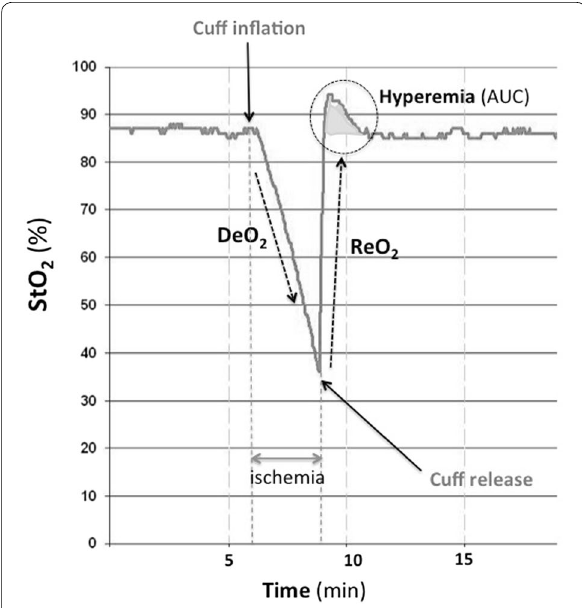
Fig. 1 StO 2 response to the Vascular Occlusion Test (VOT). The response to transient ischemia generates three main parameters in the continuous StO 2 recording: the StO 2 deoxygenation rate (DeO 2 ), the StO 2 reoxygenation rate (ReO 2 ), and the hyperemic response to ischemia, which is computed as the area under the curve of the hyperemic response ( H AUC ) as referred to steady-state StO